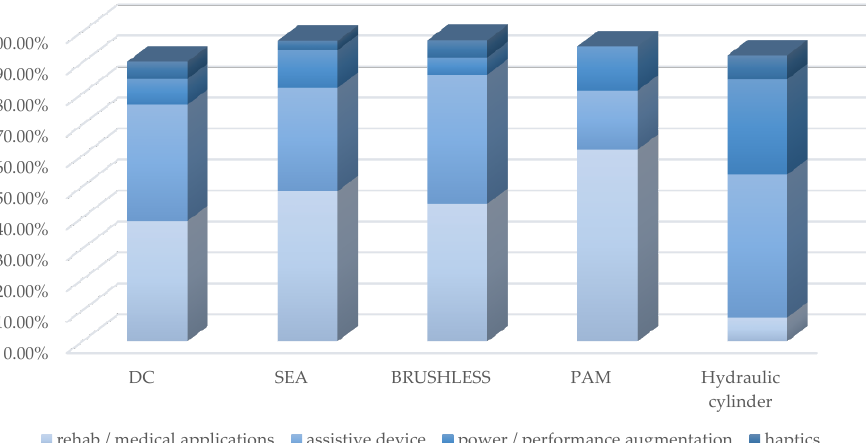
Figure 24. The distribution of the exoskeleton purpose for the most used actuator types. Medical and assistive purposes have similar weights for the most used actuators: DC, SEA and brushless motors without a clear prevalence of one over the others. For PAMs, rehabilitation/medical applications are clearly dominant